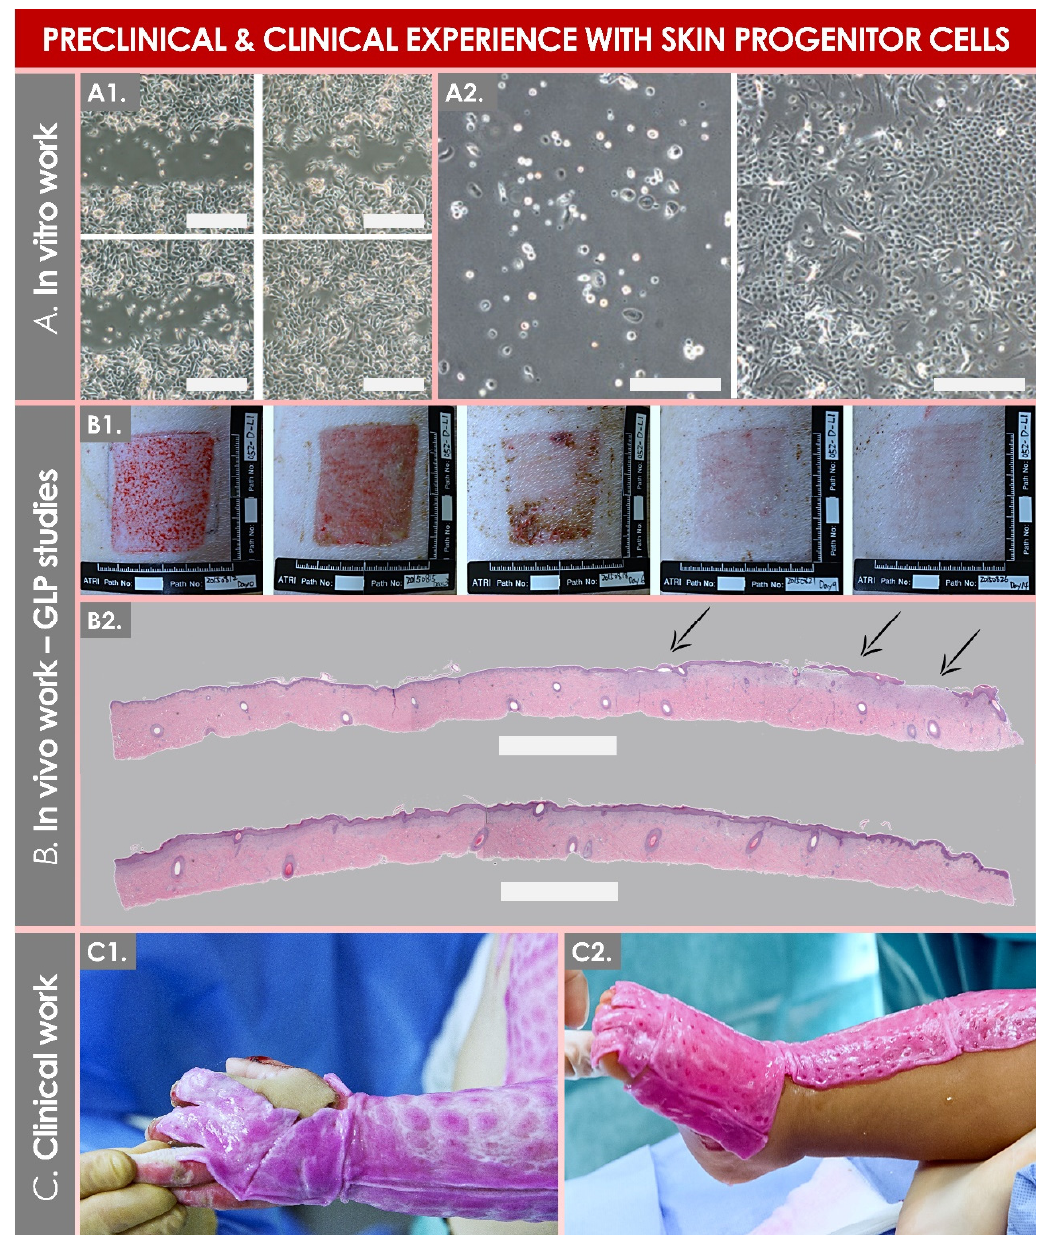
Figure 5. Illustrative overview of preclinical and clinical experience gained with primary progenitor dermal fibroblasts (e.g., FE002-SK2 cell source). ( A1 ) Results of a keratinocyte migration assay showing an increased gap closure at the 9 h timepoint (bottom quadrants) versus the 6 h timepoint (upper quadrants), with an increased relative gap-closure rate in the treatment (i.e., progenitor cell-conditioned medium) group (right quadrants). Scale bars = 50 µ m. ( A2 ) Results of a co-culture assay showing the positive effect of 6 × 10 3 progenitor fibroblasts (right panel) on the proliferation of primary keratinocytes after 6 days of co-culture, versus keratinocytes cultured alone (left panel). Scale bars = 50 µ m. ( B1 ) Photographic evolutive results of a wound-healing assay in a GLP porcine skin-excision model treated with a hydrogel containing progenitor fibroblasts over 14 days. ( B2 ) Histology results of the GLP porcine wound-healing assay, showing epidermal detachment in the sham group (upper portion, evidenced by arrows) and relatively enhanced tissue repair in the cellular-therapy group (lower portion). Scale bars = 750 µ m. ( C1 , C2 ) Photographic imaging of pediatric burn patients presenting limb cutaneous wounds and treated with progenitor biological bandages. GLP, good laboratory practices. Modified and adapted with permission from Laurent et al., 2020, 2021